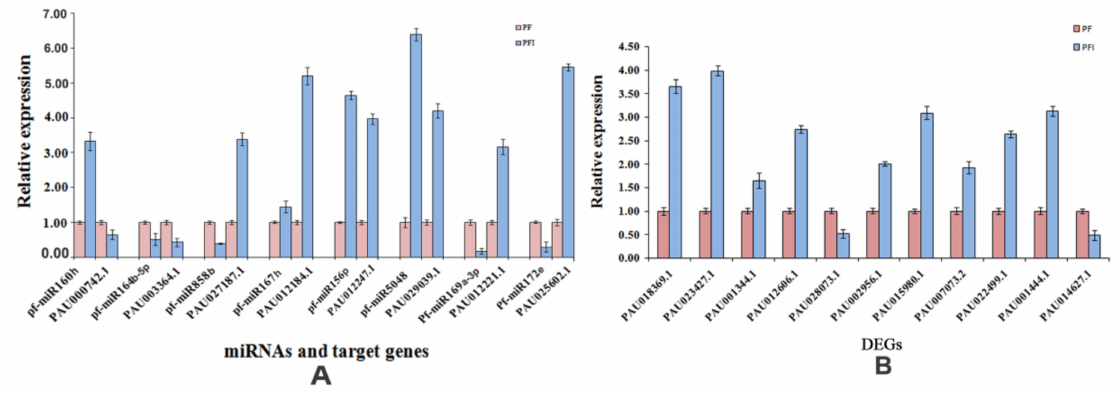
Figure 8. Quantificational real-time polymerase-PCR analysis of eight DER-target pairs and 11 DEGs in Paulownia fortunei . ( A ) miRNA and target genes; ( B )